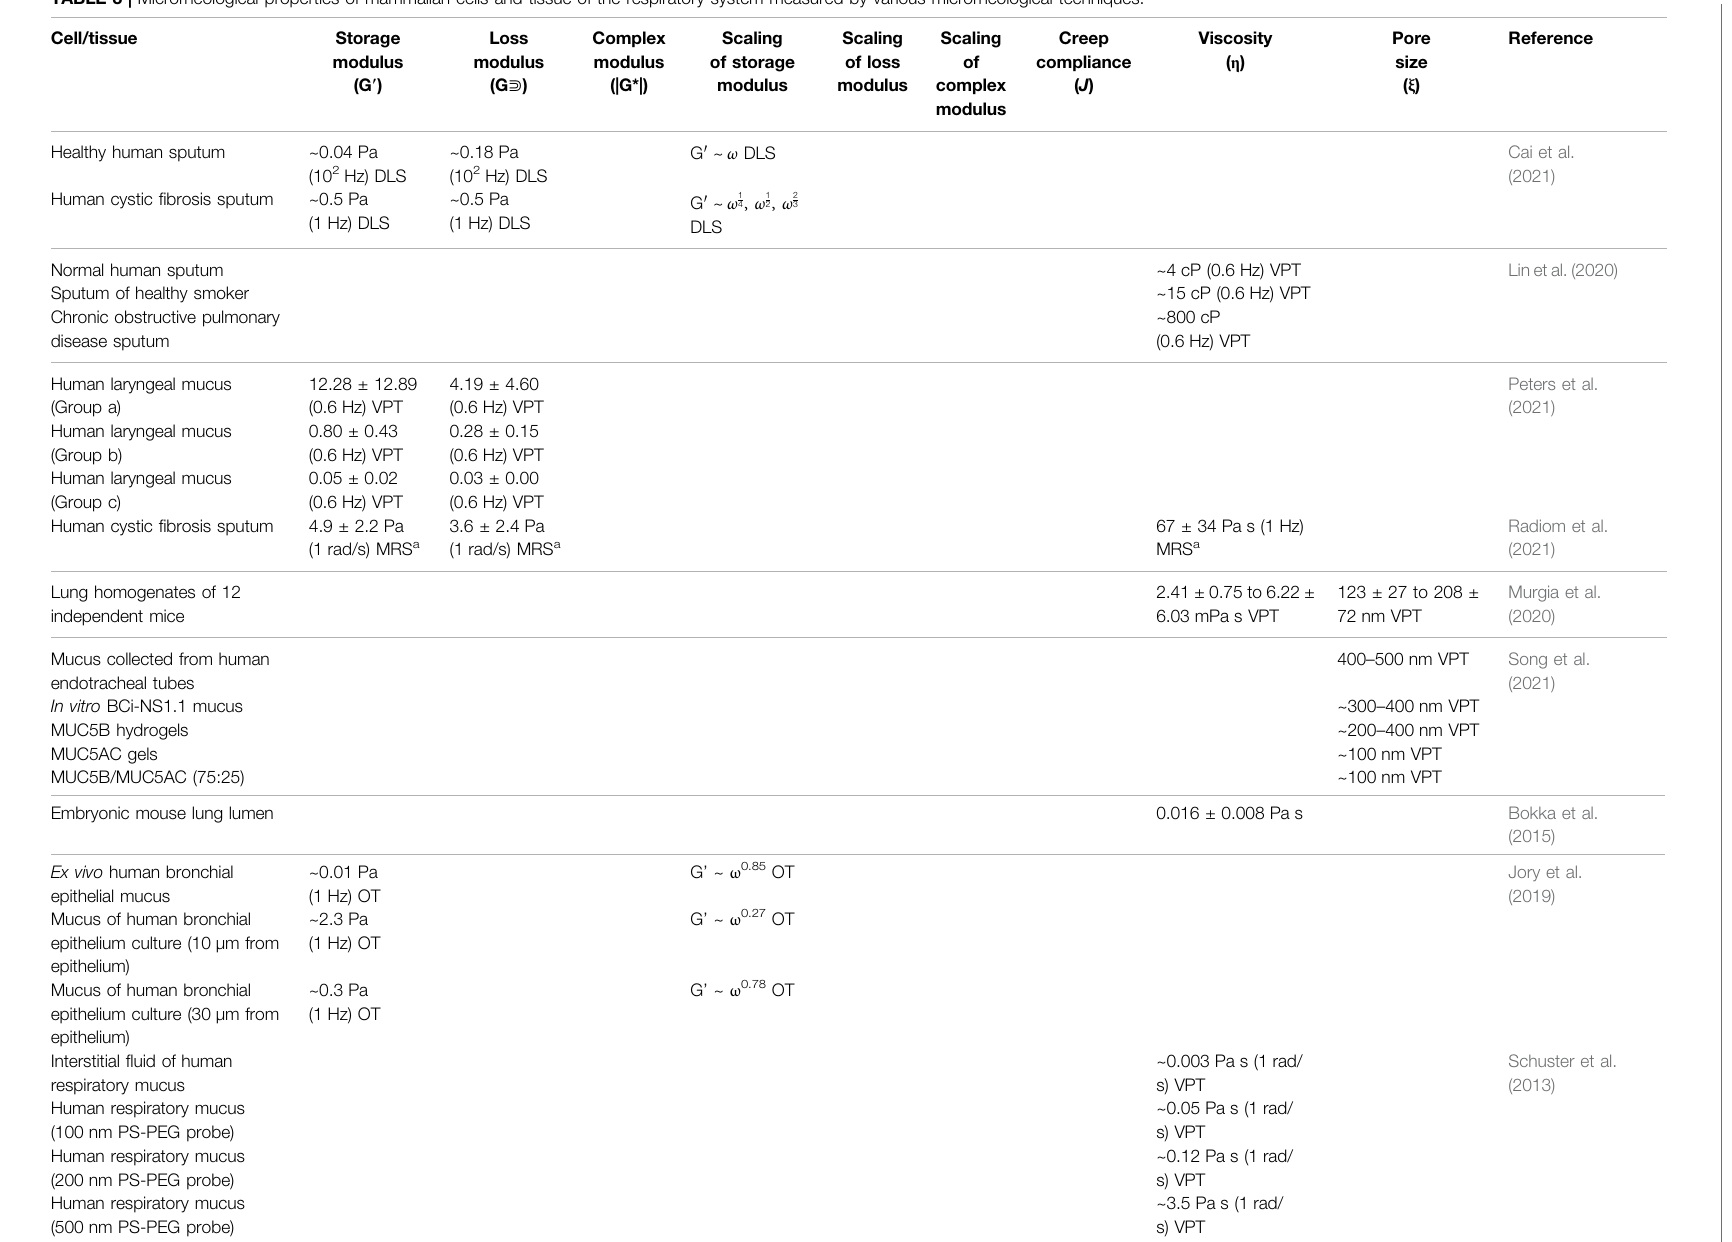
TABLE 3 | Microrheological properties of mammalian cells and tissue of the respiratory system measured by various microrheological